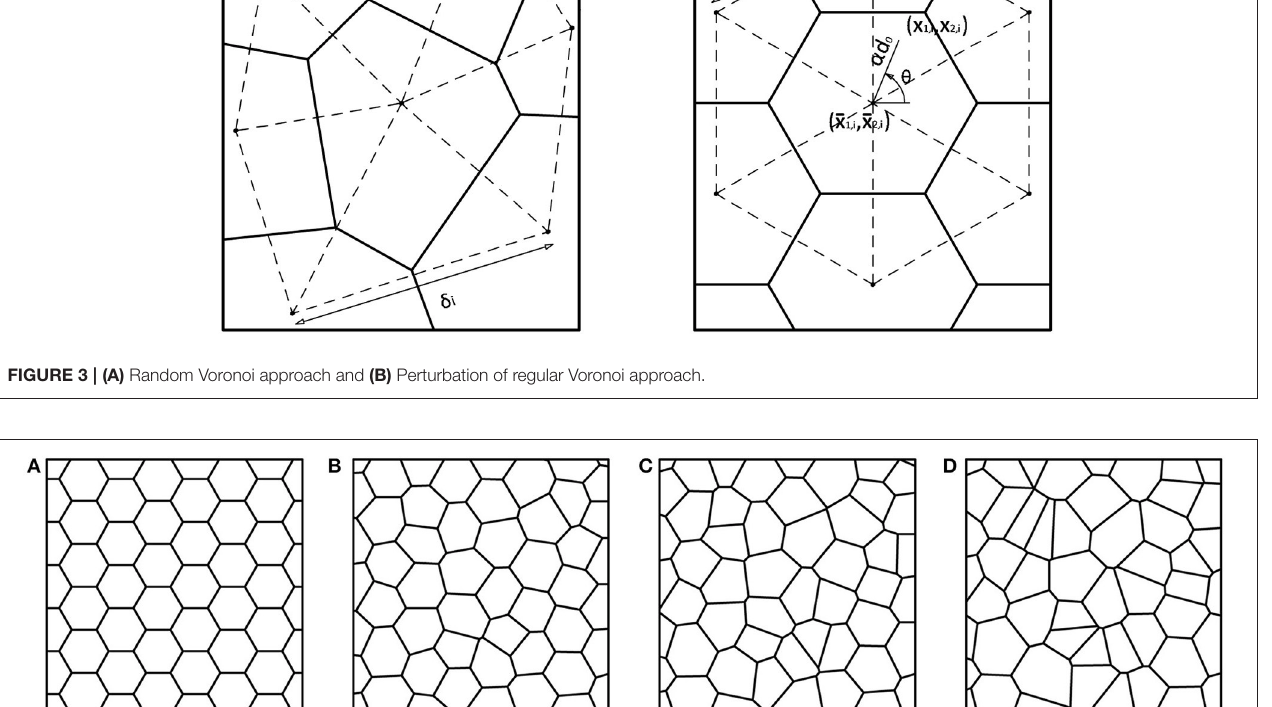
0, (B) α 0.5, (C) α 0.7, and (D) fully random α = = =